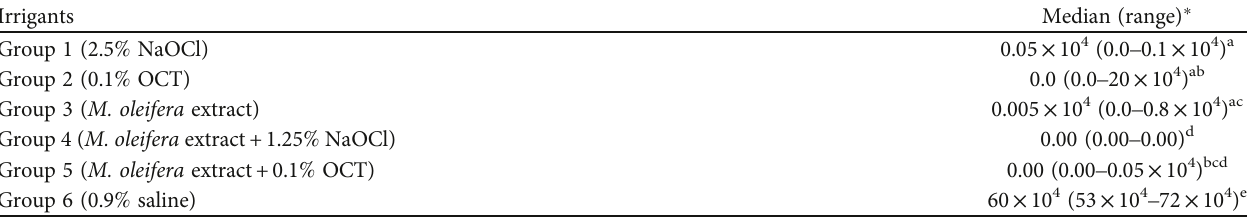
∗ Data labeled with different letters are signi fi cantly different from each other ( P < 0 :